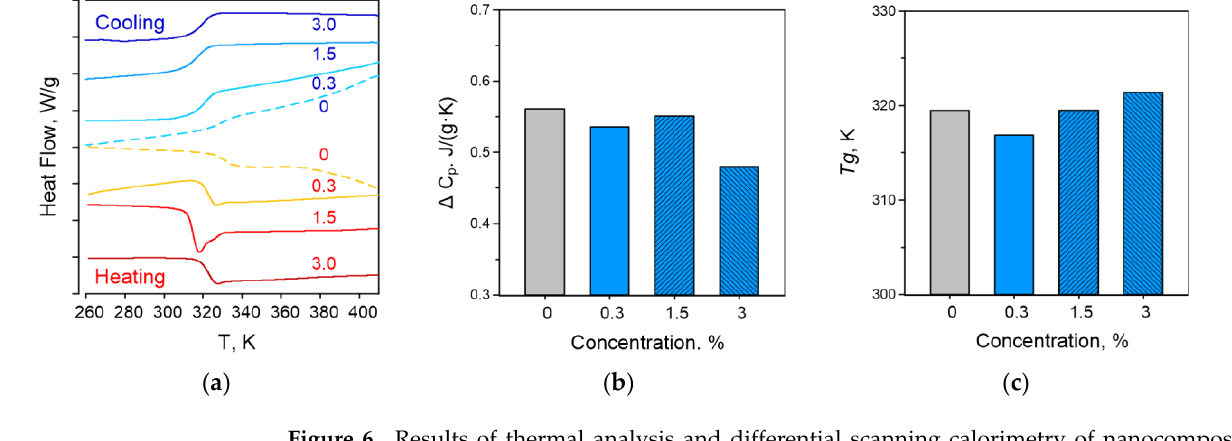
Figure 6. Results of thermal analysis and differential scanning calorimetry of nanocomposites: ( a ) Thermograms obtained in heating and cooling mode; ( b ) Glass transition temperatures of samples; ( c ) Change in the heat capacity.